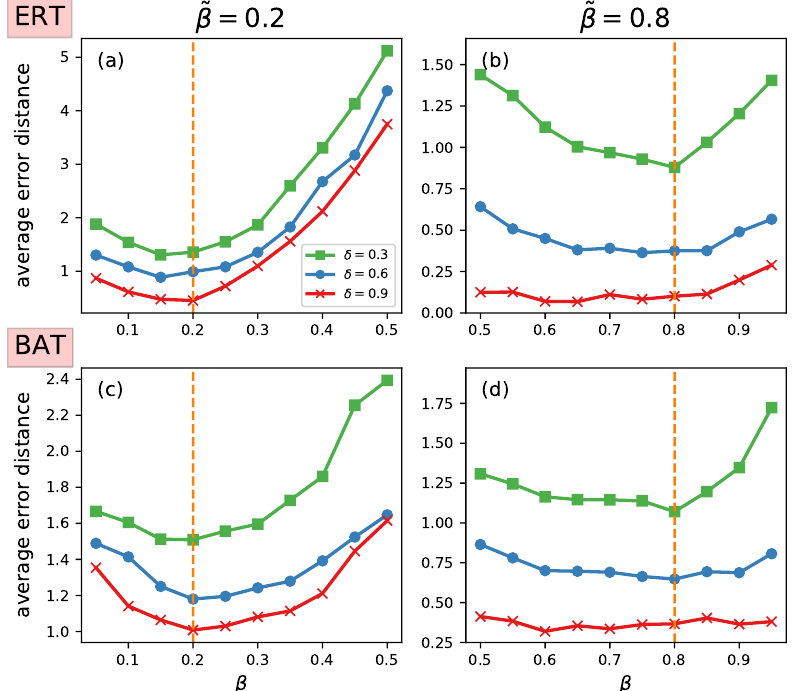
Figure 6. The algorithm performance with unknown infection probability. ( a , c ) represent the relationship between average error distance and β when ˜ β = 0.2 in ERT and BAT respectively. ( b , d ) represent the relationship between average error distance and β when ˜ β = 0.8 in ERT and BAT respectively. The x-axis in the figure represents the parameter β used in the PESL algorithm and the vertical dotted line denotes the true infection probability ˜ β in the SIR model. Reporting probability of nodes is δ = 0.3,0.6,0.9